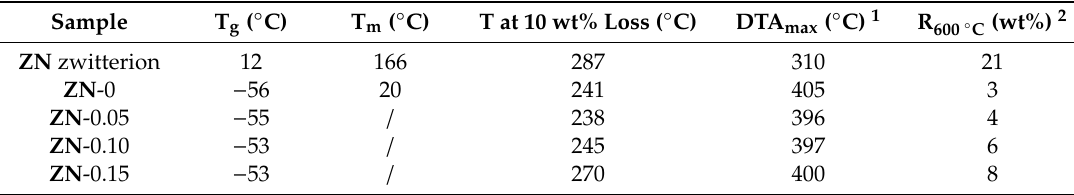
Figure 1. TGA curves of ZN molecule and the investigated electrolyte solutions with and without ZN . Table 2. Summary of TGA and di ff erential scanning calorimetry (DSC) studies of the ZN molecule and investigated